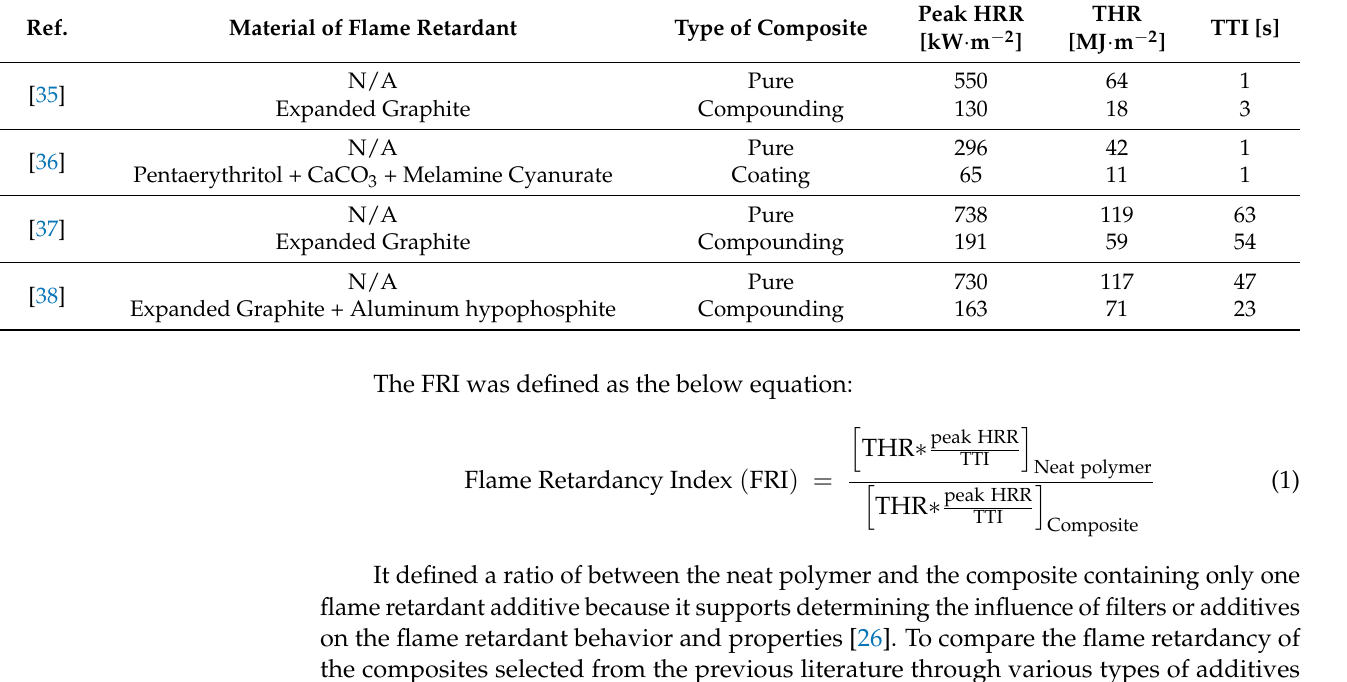
Table 6. Cone calorimeter results on peak HRR, THR, TTI values of polystyrene composites. Ref.